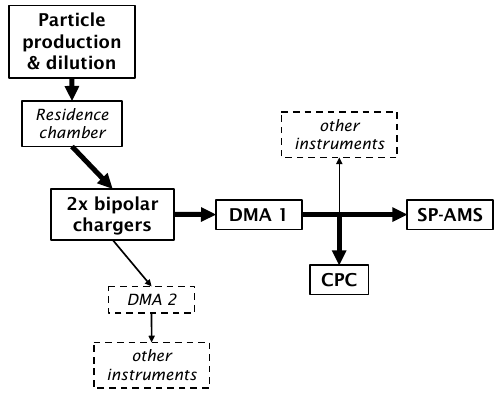
Fig. 1. Laboratory setup used for all samples except turbine par- ticles. Aerosols were diluted before passing through a 1m 3 resi- dence chamber with residence time ∼ 30min. Particles then flowed through two bipolar chargers at 4Lmin − 1 before being split equally between two